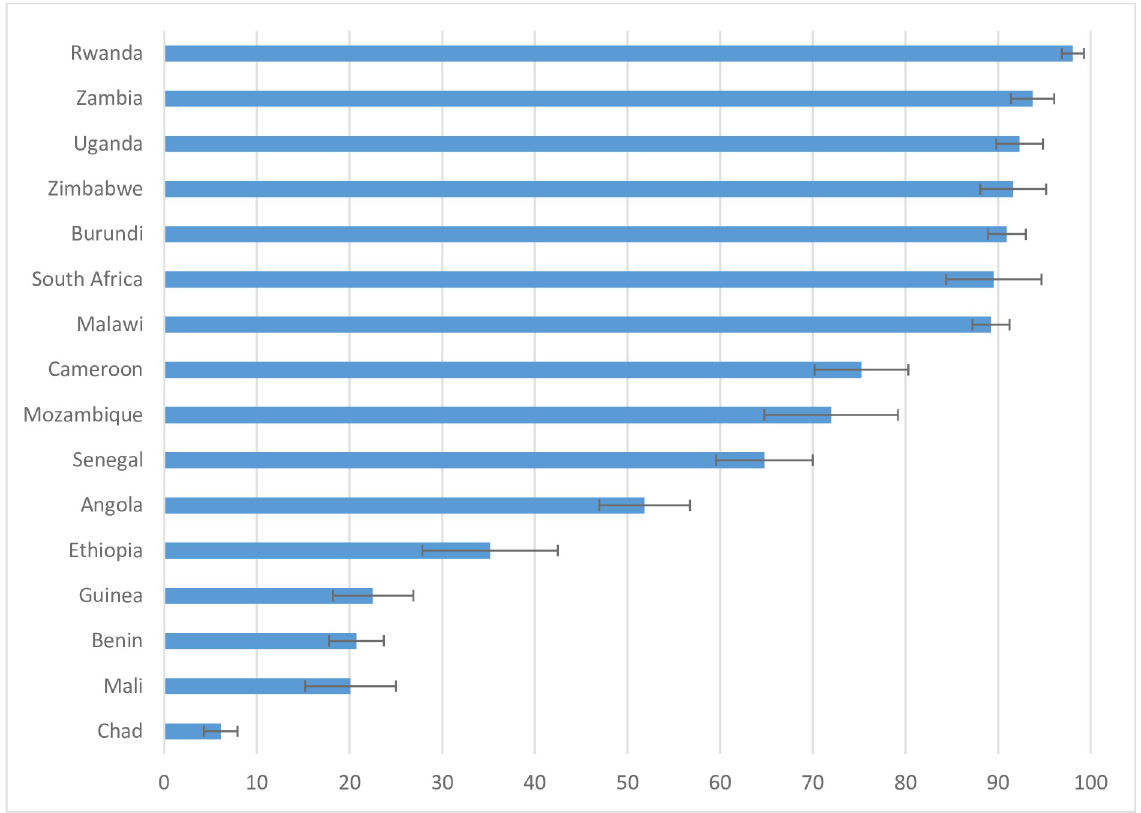
Fig 2. Uptake of HIV testing during pregnancy across SSA